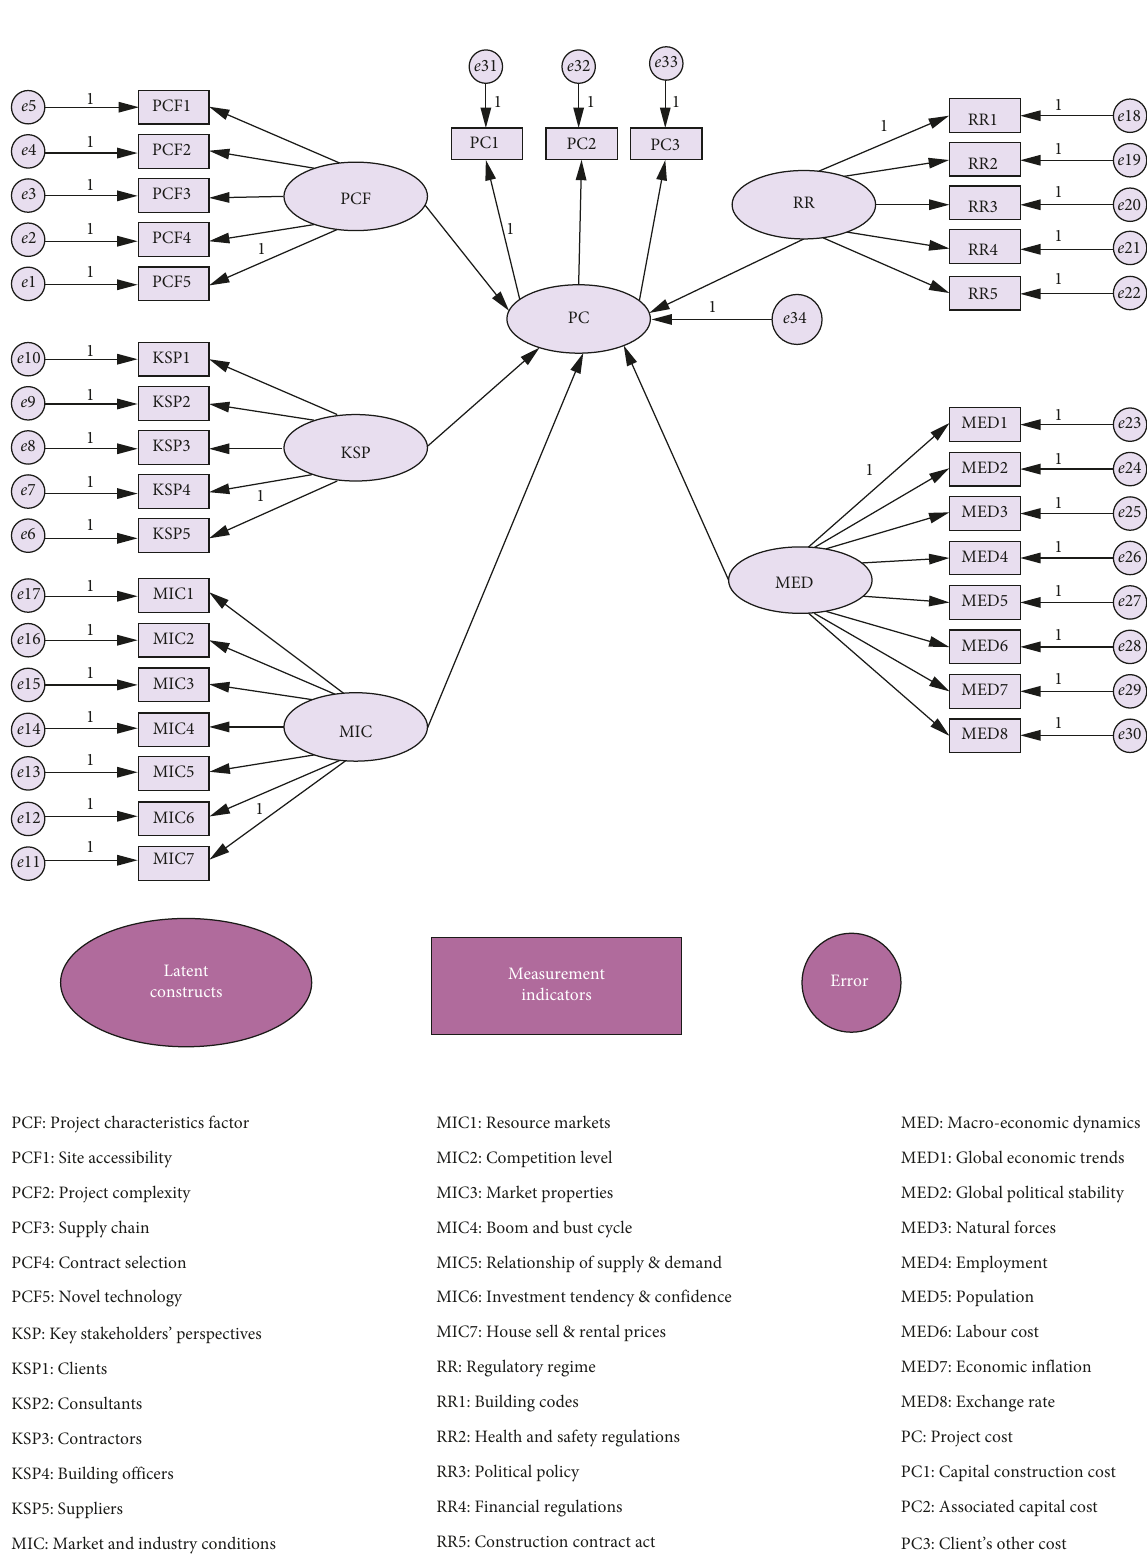
Figure 1: The proposed research